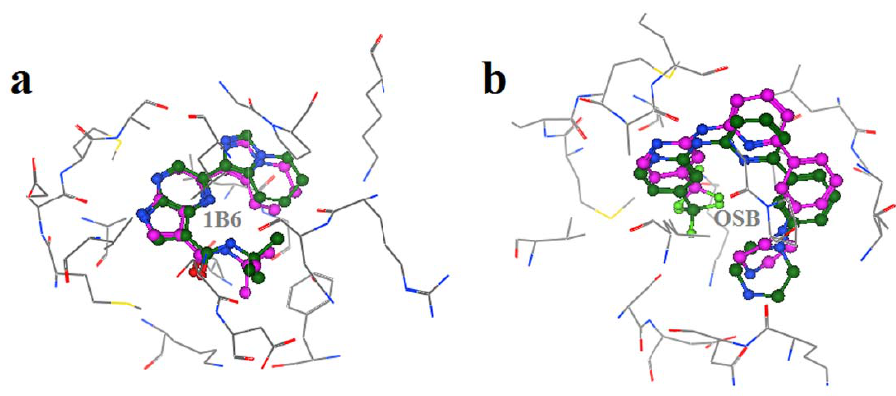
e 6. ( a ) Sup with Syk (pu